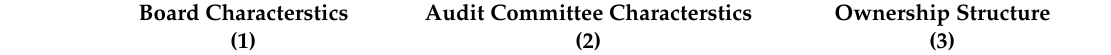
Table 7. Regression results of the three categories separately.